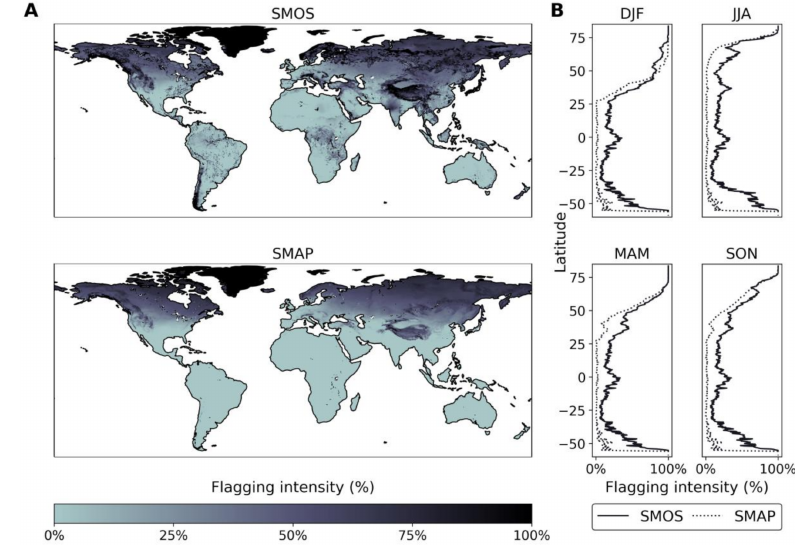
Figure 7. ( a ). Global maps of the flagging intensities over the period 2016–2019 per dataset (left). ( b ). Latitudinal plots of percentage of flagged values over the period 2016–2019 per season in which the solid line represents the SMOS SM dataset and the dotted line the SMAP SM dataset